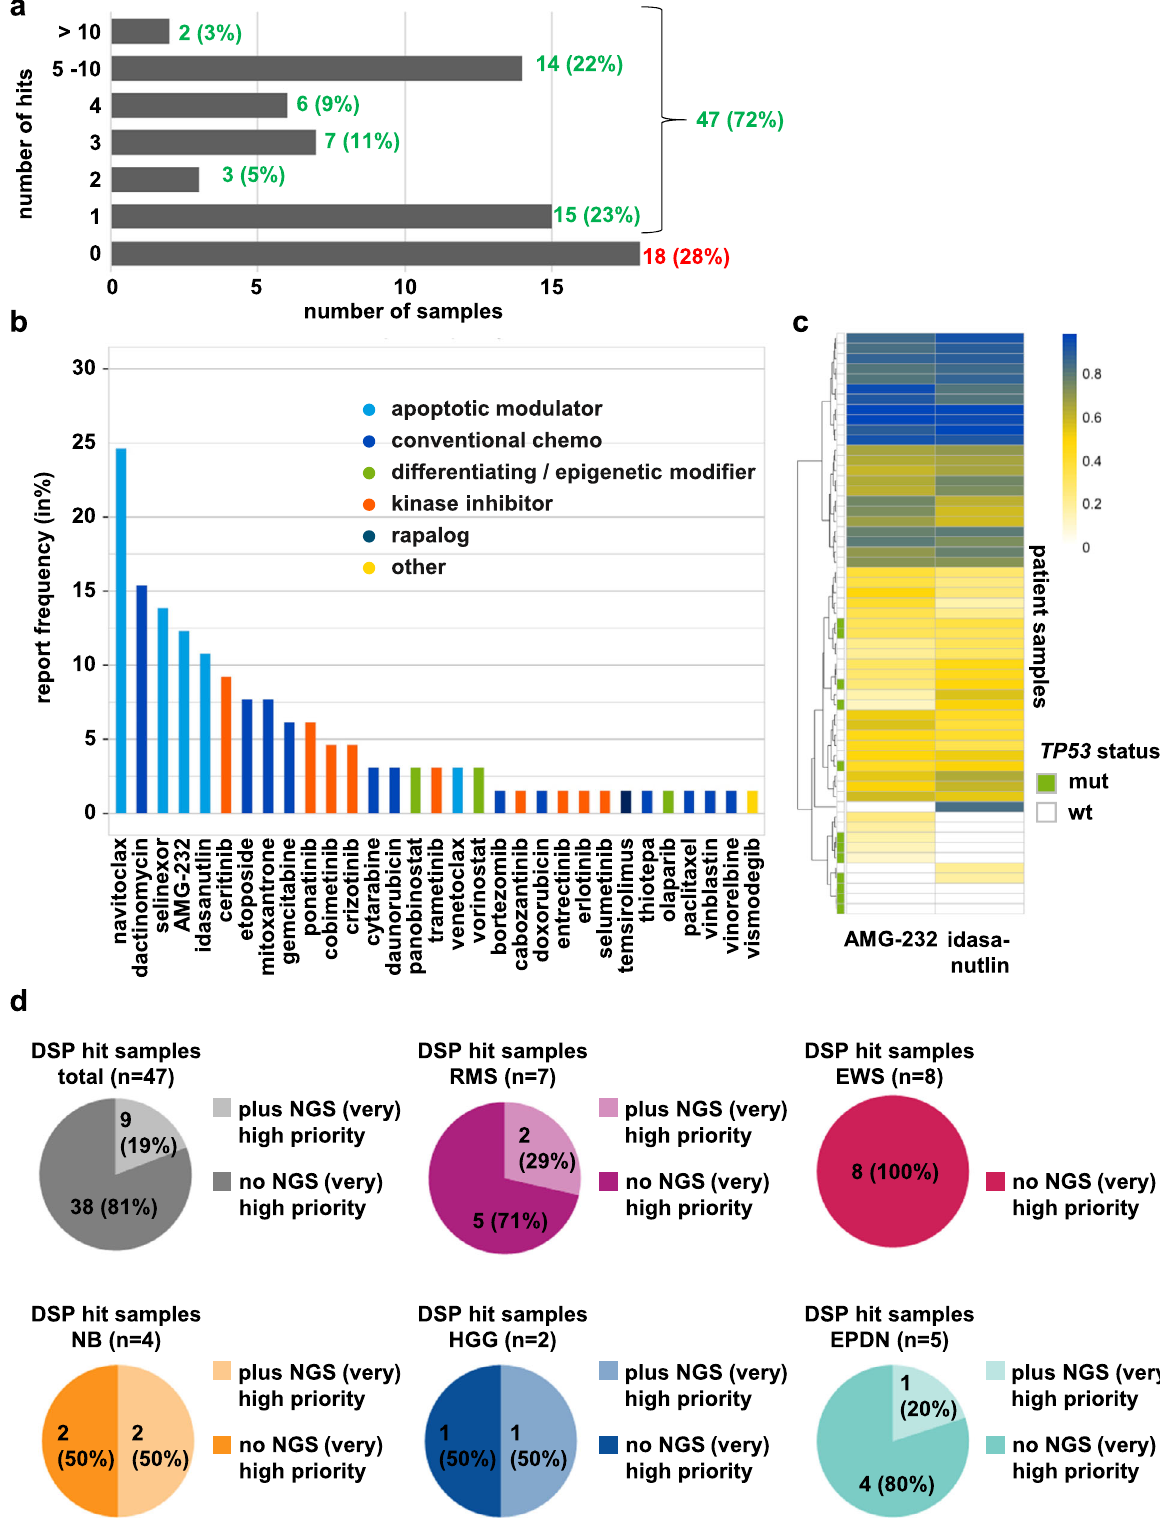
Fig. 6 Identi fi ed drug hits reported to the INFORM molecular tumor board. a Bar diagram displaying the number of reported hits per sample and in %. b Bar diagram depicting the report frequency (in %) of single drugs and drug classes. Color code integrated. c Unsupervised hierarchical clustering based on DSS asym quantiles for the MDM2 inhibitors AMG-232 and idasanutlin. The color scale shown at the top represents quantile values. The TP53 status is highlighted with green (mutant) and white (wild-type) bars on the left side. d Pie diagrams re fl ecting the proportion of samples with reported hits with or without reported NGS (very) high-evidence targets for the total DSP cohort and different